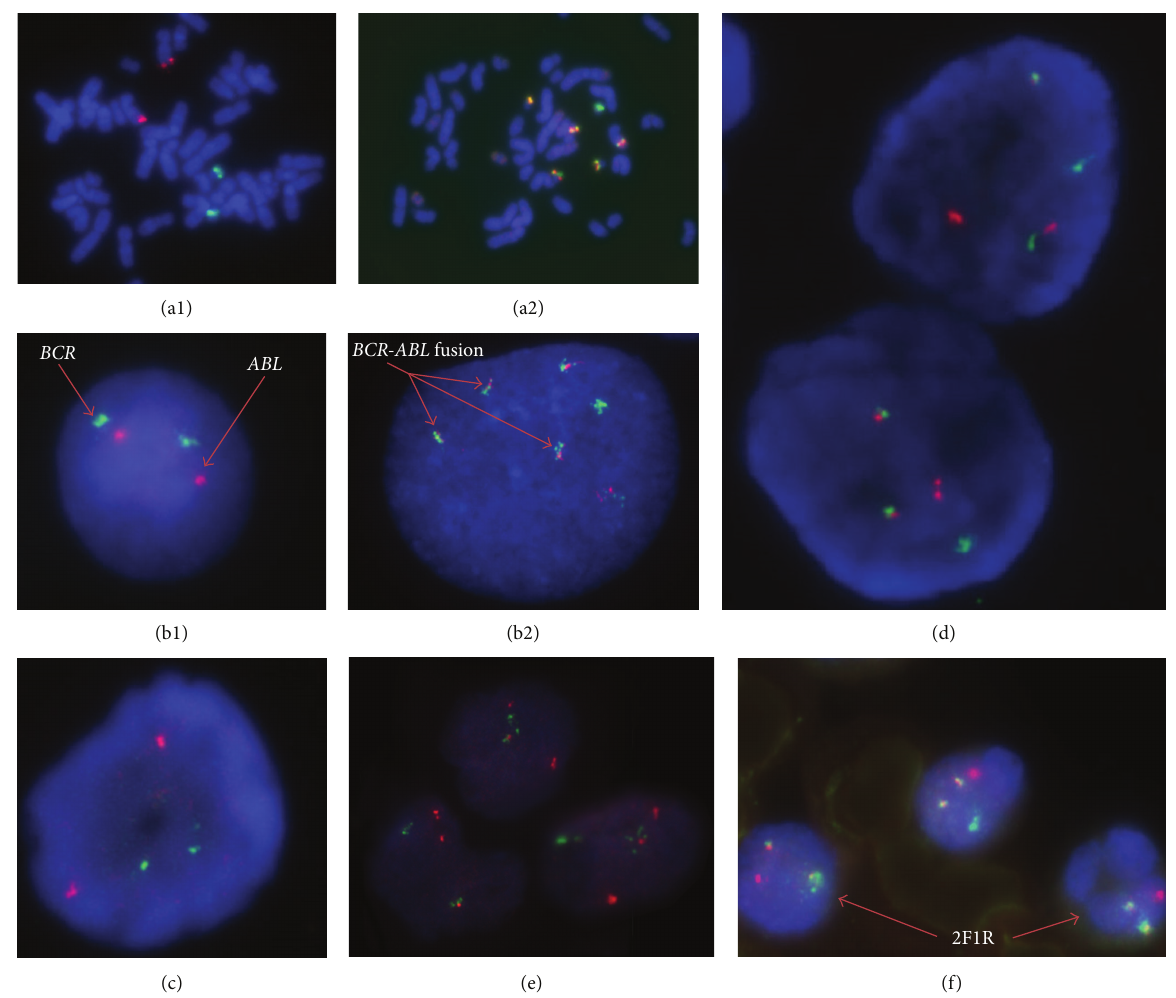
Figure 1: BCR-ABL dual colour, dual fusion translocation probe hybridized to controls, and subject’s bone marrow and peripheral blood smears. ((a1) and (b1)) Two red, two green (2R2G), negative control in a metaphase cell and an interphase cell, respectively; ((a2) and (b2)) five fusion, one green (5F1G), positive control in a metaphase and an interphase cell, respectively. (c) BCR-ABL negative FISH signal in a subject’s peripheral blood smears. (d) 2F1R1G signals in a BCR-ABL positive subject BM smear. (e) 1F2R1G signals in a BCR-ABL